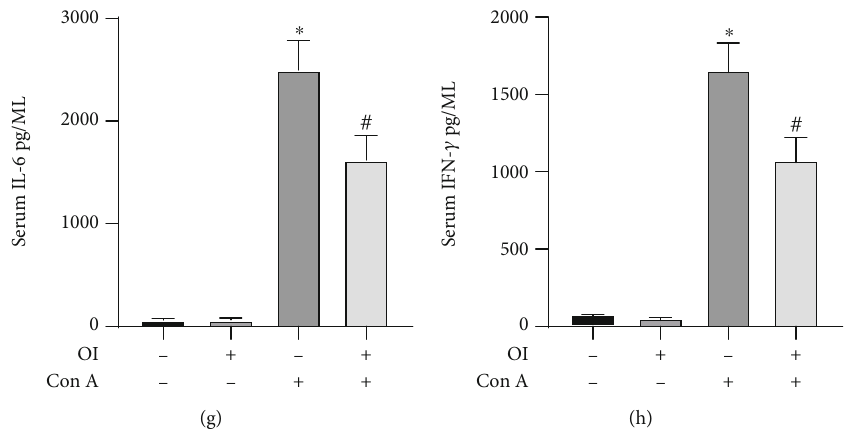
Figure 2: OI reduced Con A-induced macrophage in fi ltration and expression of proin fl ammatory cytokines in mice. (a) Representative immuno fl uorescence micrographs showed that the F4/80-positive cells in each group and the (b) positive cells in each group were evaluated. (c, d) Immuno fl uorescence for CD4-positive staining cells of the liver tissue. The serum levels of proin fl ammatory cytokines including (e) TNF- α , (f) IL-1 β , (g) IL-6, and (h) IFN- γ were measured in each group. Data are expressed as mean ± SEM ( n = 6 ). ∗ p < 0 : 05 vs. control group. # p < 0 : 05 vs. Con A